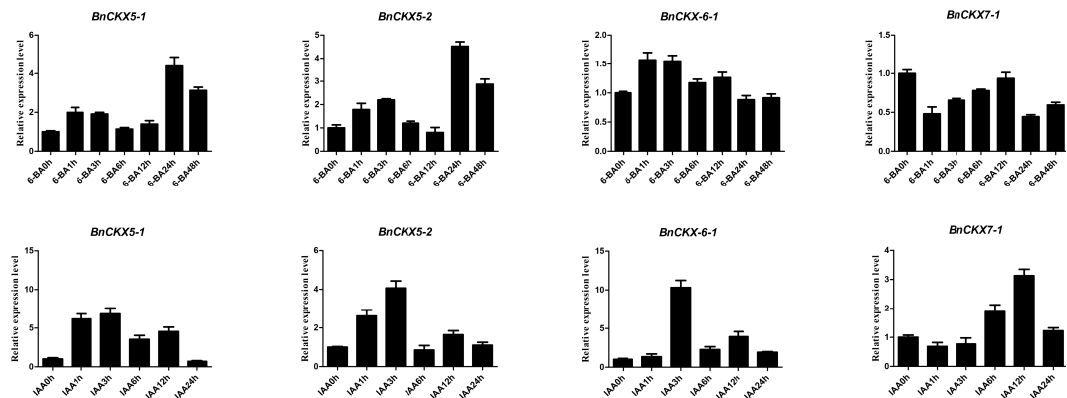
Figure 8. Responses of differentially expressed BnCKX genes to 6-benzylaminopurine (6-BA) and indole-3-acetic acid (IAA) treatment. IAA 0 h: control sample; IAA 1, 3, 6, 12, 24 h: sample treated for 1, 3, 6, 12 and 24 hours with IAA; 6-BA 0 h: control sample; 6-BA 1, 3, 6, 12, 24, 48 h: sample treated for 1, 3, 6, 12, 24, and 48 hours with 6-BA. **: p <0.01. *: p <0.05.